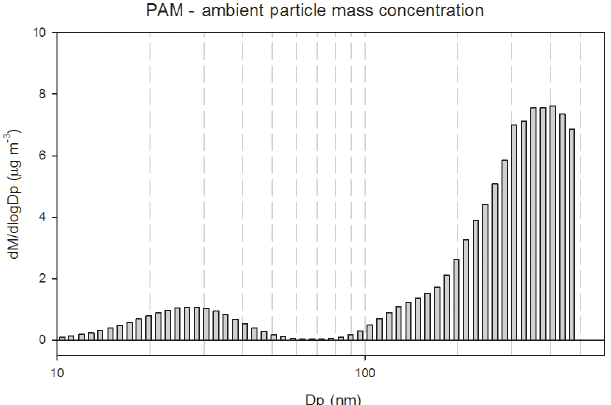
Figure 3. SMPS mass concentration difference between PAM and ambient aerosol particles averaged for the entire sampling